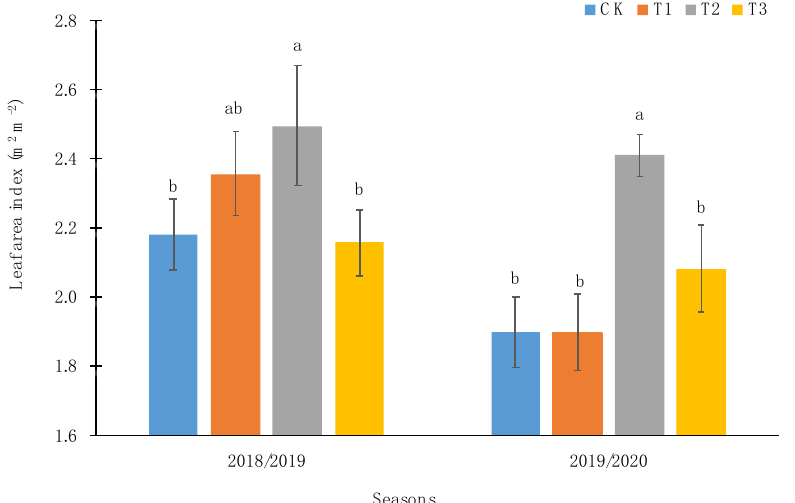
Figure 2. Leaf area index (LAI; m 2 m − 2 ) of calafate ( Berberis mycrophilla G. Forst) for the different compost treatments for the 2018–2019 and 2019–2020 seasons. For each figure: CK = Control treatment (without compost application); T1 = Treatment 1 (5 Ton ha − 1 ); T2 = Treatment 2 (10 Ton ha − 1 ); T3 = Treatment 3 (15 Ton ha − 1 ). For each season, different lowercase letters indicate significant differences for the leaf area index between treatments according to Fischer’s LSD test ( p < 0.05). The bars correspond to the experimental error of each treatment.